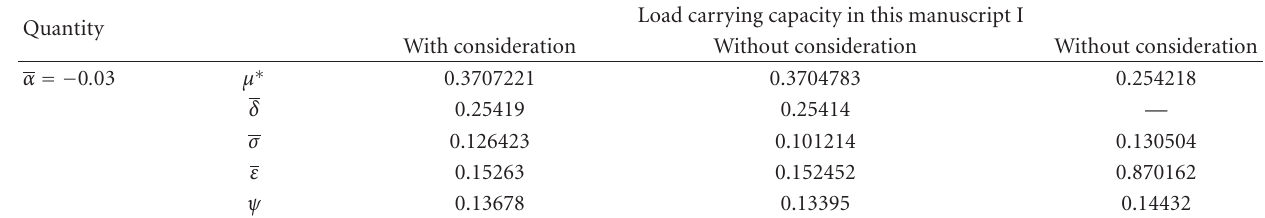
Load carrying capacity in this manuscript I Quantity With consideration Without consideration Without